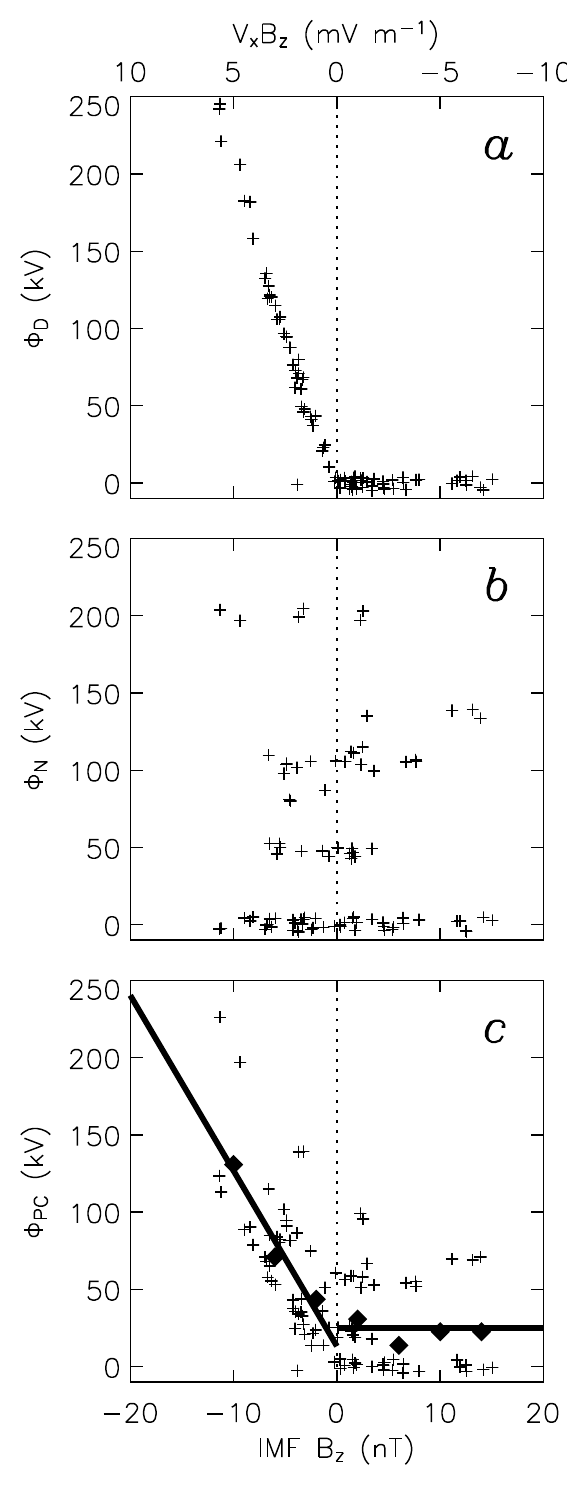
Fig. 2. ( a ) Dayside reconnection rate, ( b ) nightside reconnection rate, and (c) cross polar cap potential as a function of IMF B z . In ( c ) solid curves show a least-squares fit in the interval B z < 0nT, and the average value in the interval B z > 0nT. Diamonds show average values of cross polar cap potential in 4nT-wide bins of B z